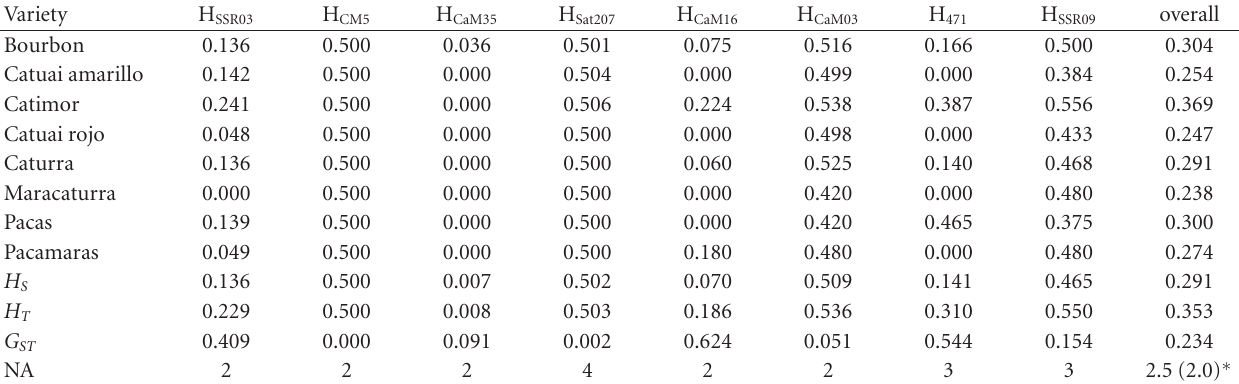
Table 3: The partitioning of total gene diversity into within and among variety components for eight polymorphic SSR loci, and the number of alleles observed at each